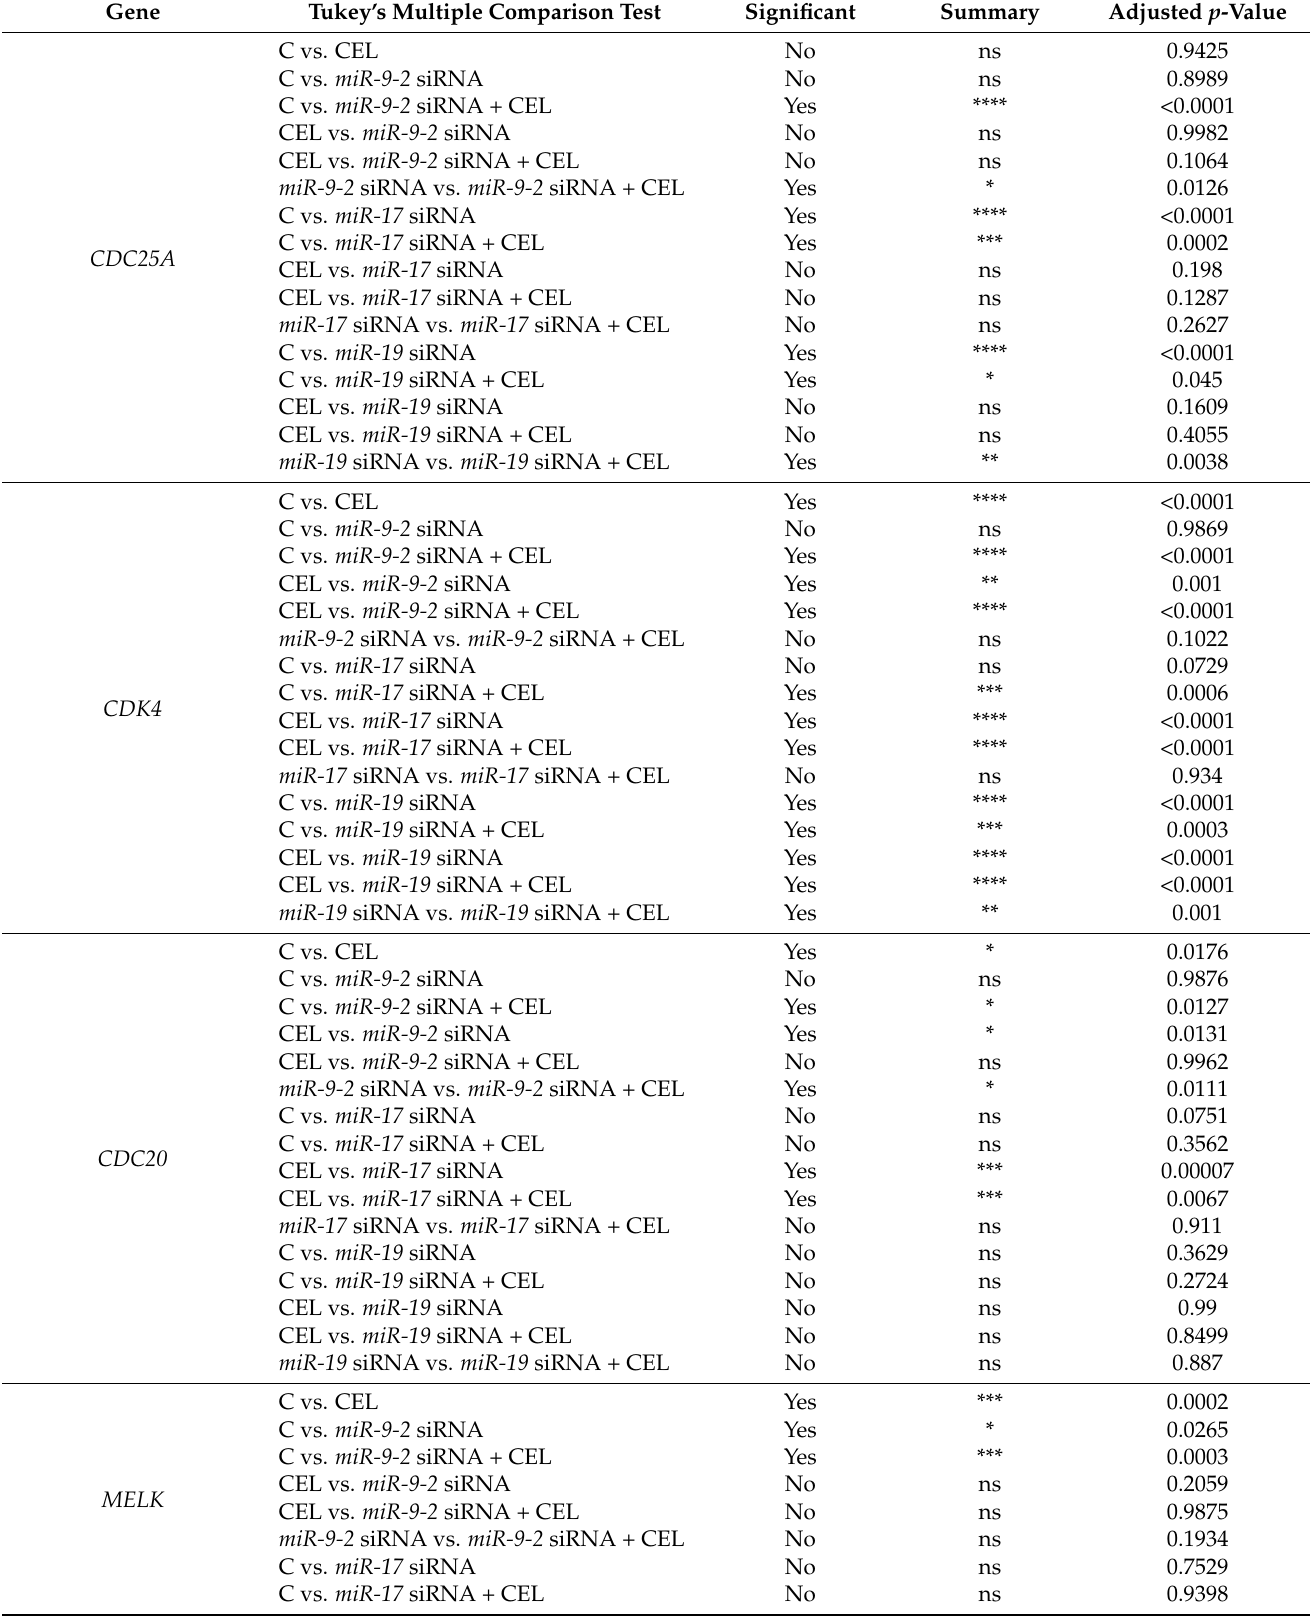
Table 2. Results of the one-way ANOVA followed by Tukey’s post-hoc test in Figure 2.